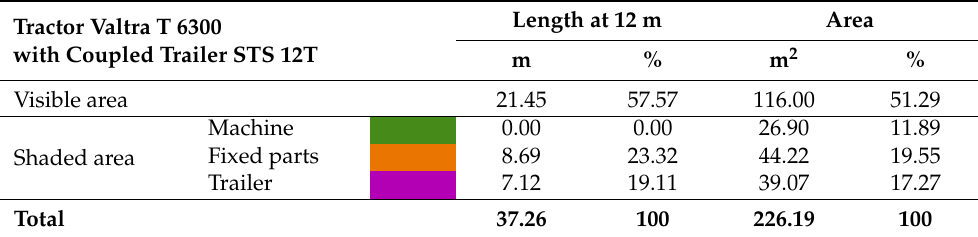
Table 3. Data on length and area, characterizing the rear view of the driver of agricultural tractor (trailer at an angle of 35 ◦ from the longitudinal axis of the tractor).